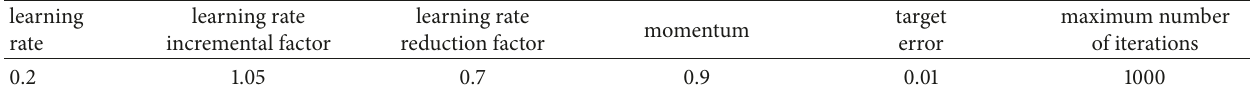
Table 1: Network parameter table.